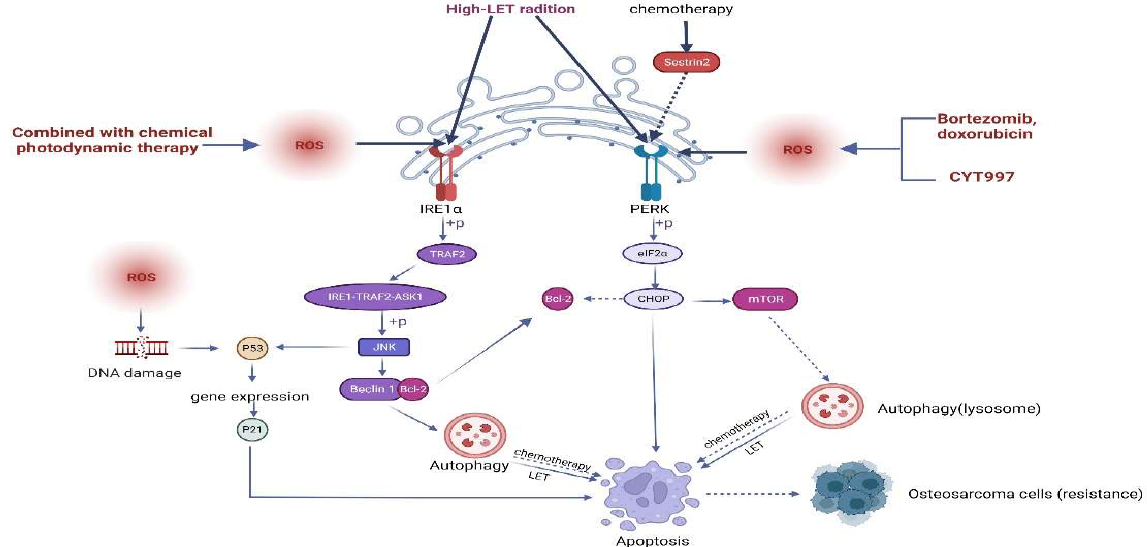
Figure 2. Crosstalk of ERS with autophagy and oxidative stress. The intracellular induction of the Sestrin2/PERK/p-eIF2α/CHOP/mTOR/autophagy axis protects osteosarcoma cells during chemo- therapy, leading to the chemoresistance of cells. The intracellular induction of apoptosis via the PERK/p-eIF2α/CHOP/mTOR/autophagy axis and IRE1/TRAF2/ASK1/JNK/autophagy pathway in osteosarcoma cells during high LET radiation treatment induces cellular sensitivity to strong LET radiation. When CYT997 and bortezomib in combination with adriamycin were used to treat osteo- sarcoma, intracellularly generated oxidative stress induced apoptosis through PERK/eIF2α/CHOP axis regulation. When combined photodynamic therapy was administered, intracellularly triggered oxidative stress in osteosarcoma cells induced apoptosis through JNK/p53/p21 pathway regulation. This figure has been created using https://app.biorender.com (accessed on 20 July